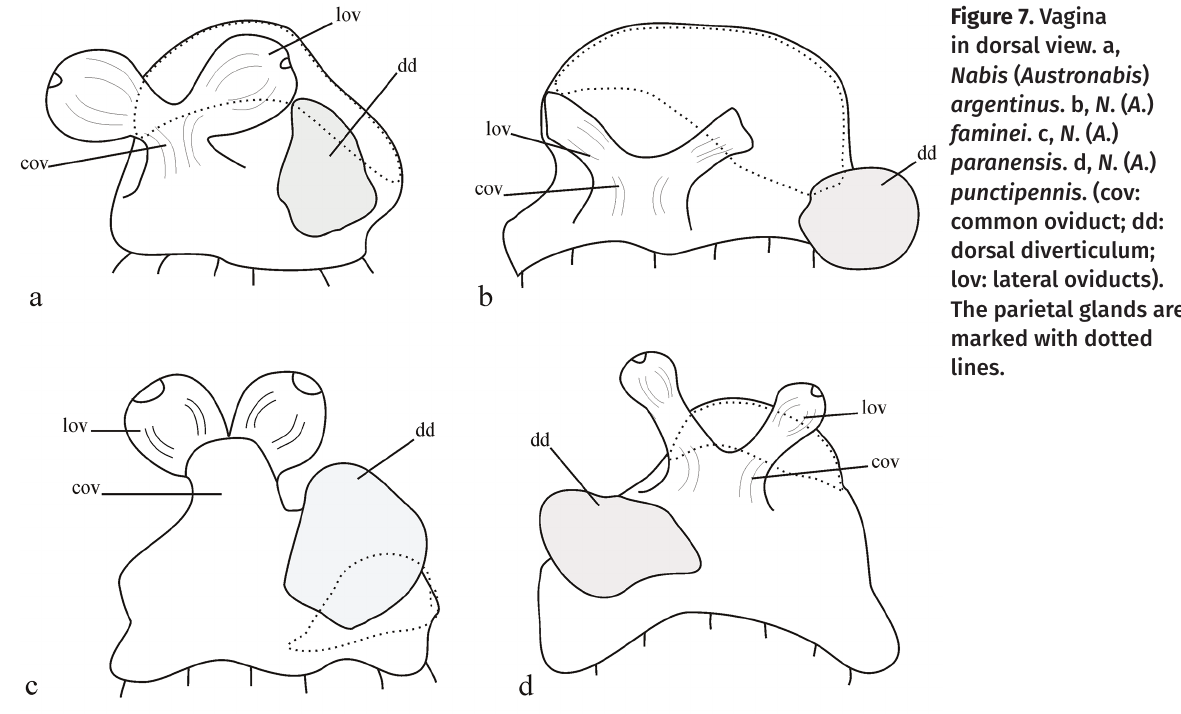
Figure 7. Vagina in dorsal view. a, Nabis ( Austronabis ) argentinus . b, N . ( A .) faminei . c, N . ( A .) paranensis . d, N . ( A .) punctipennis . (cov: common oviduct; dd: dorsal